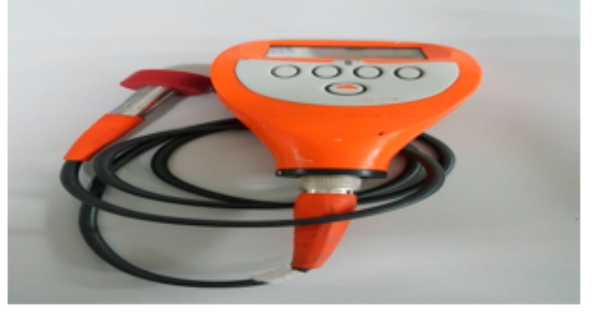
Figure 4. Dry film thickness measure.